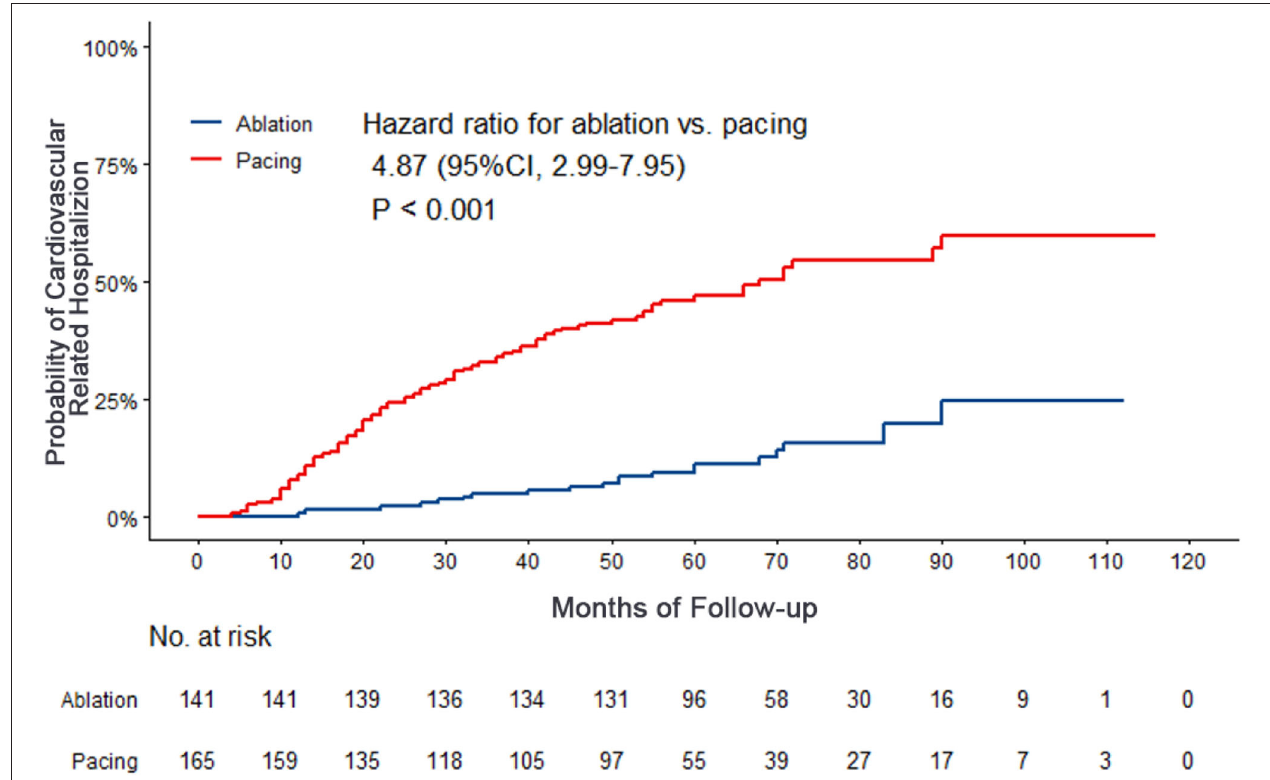
FIGURE 3 | Kaplan–Meier curves comparing probability of cardiovascular related hospitalization. Month 0 is the time of the baseline